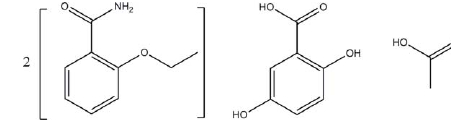
Experimental Crystal data